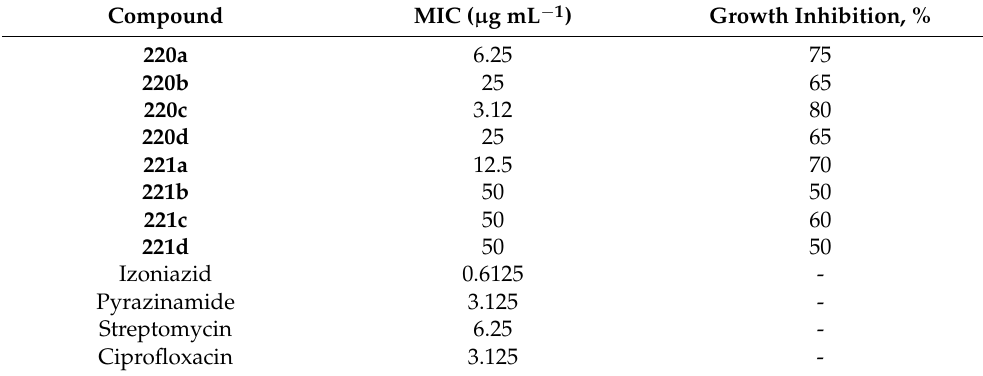
Table 14. In vitro antitubercular activity of compounds 220a and 221 in comparison to some reference